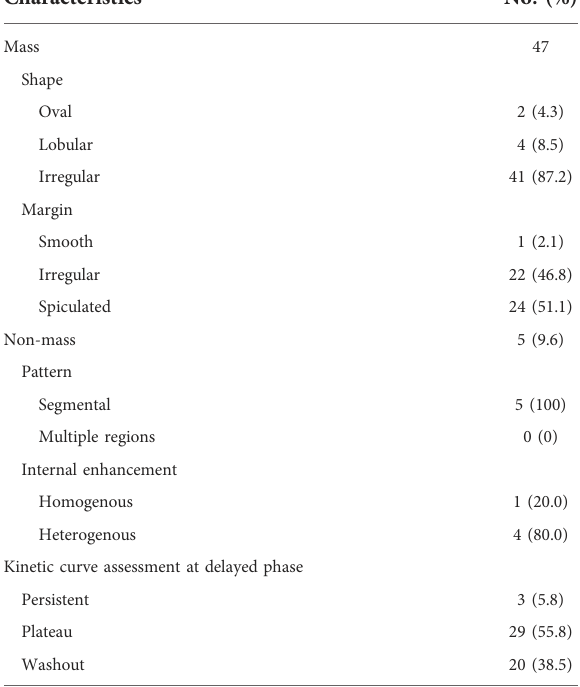
TABLE 4 MRI characteristics of IMPC lesions ( n =52).